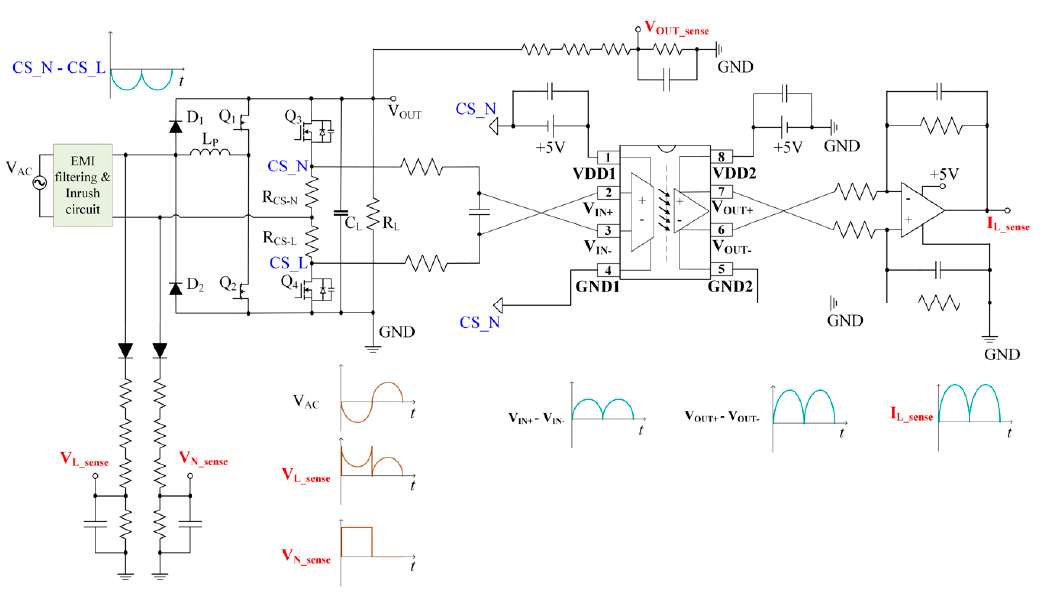
Figure 4. Sensing circuit of the proposed design.